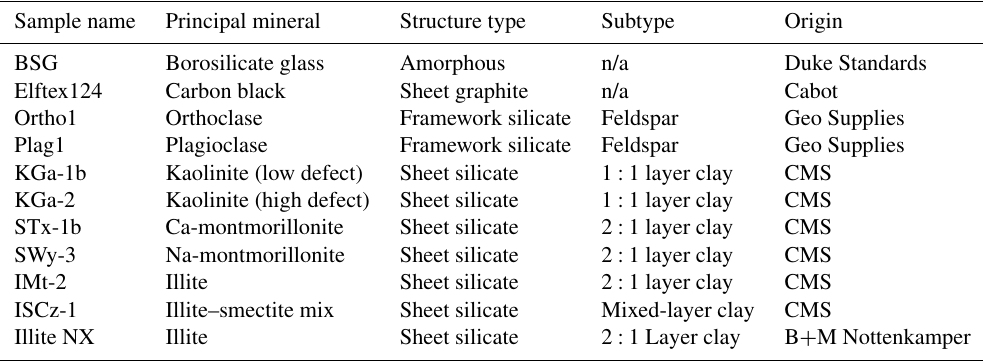
Table 1. Summary of the dust samples used in this study (n/a = not